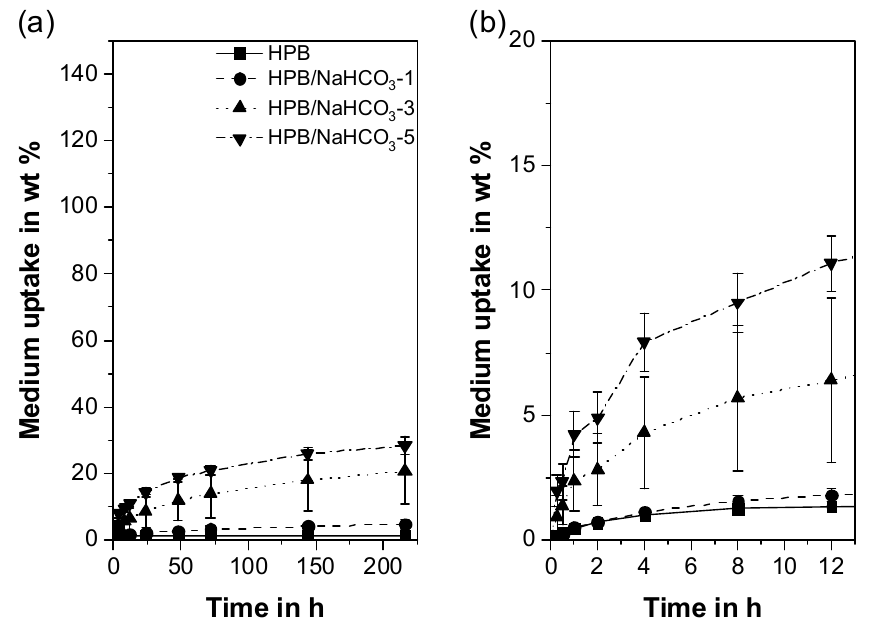
Figure 8. Liquid uptake kinetics for formulations comprising hydrophobic thermoplastic polyurethane (HPB) without and with NaHCO 3 ( a ) over a period of 9 days ( a ) and ( b ) a more precise representation of the first 12 h.